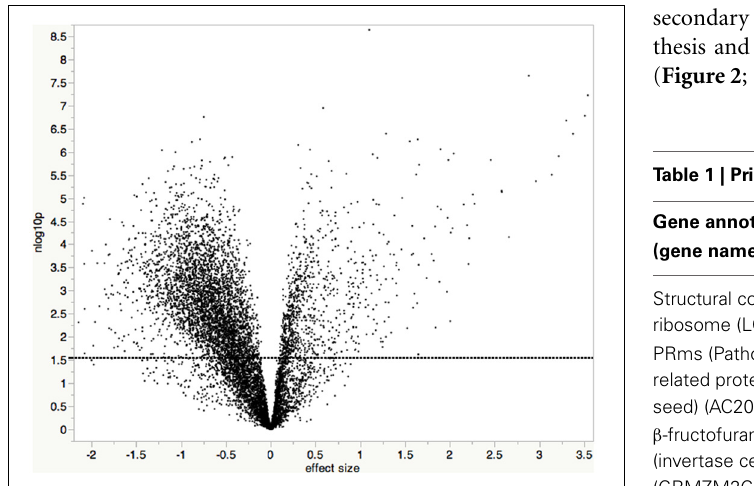
FIGURE 1 | Volcano plot of test results showing statistical significance vs. fold change. Each point represents the results of one gene, where the x-axis is the difference in expression between A. flavus -infected samples and mock-infected samples (log 2 [ A. flavus ]—log 2 [mock]). The y-axis is the –log 10 transformed p -value. The dashed line indicates the significance threshold based on an FDR of 0.05 (Benjamini and Hochberg, 1995); all points above the line are considered statistically significant.